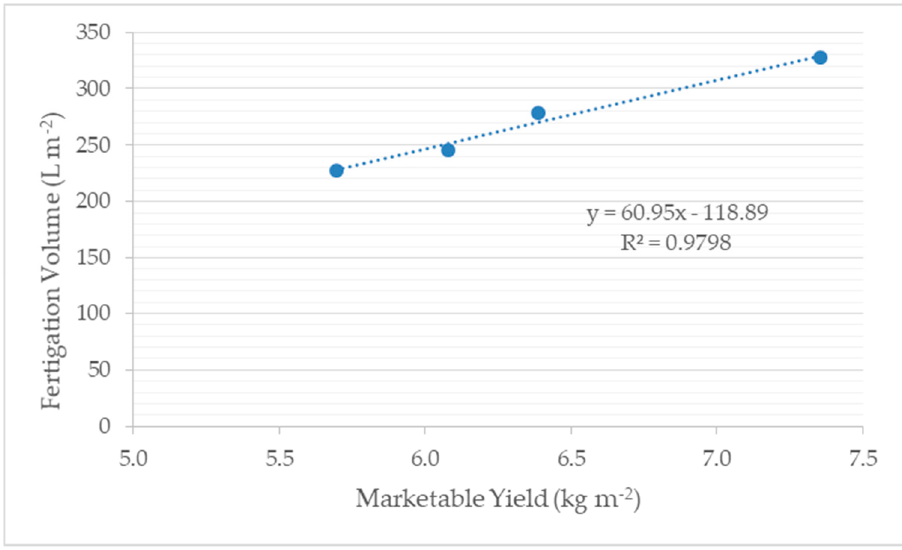
Figure 5. Linear relationship between total marketable yield and fertigation volume